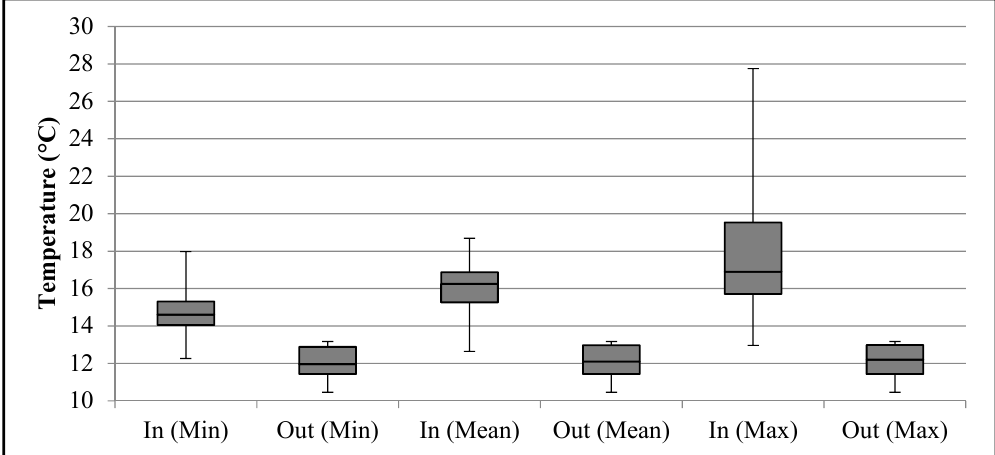
Figure 5. Summer Inlet and Outlet Temperatures during runoff events: minimum, mean and maximum.